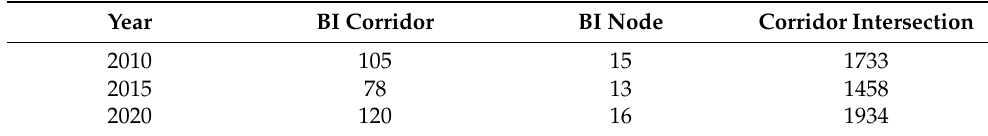
Table 5. Statistics on the number of BI corridors and